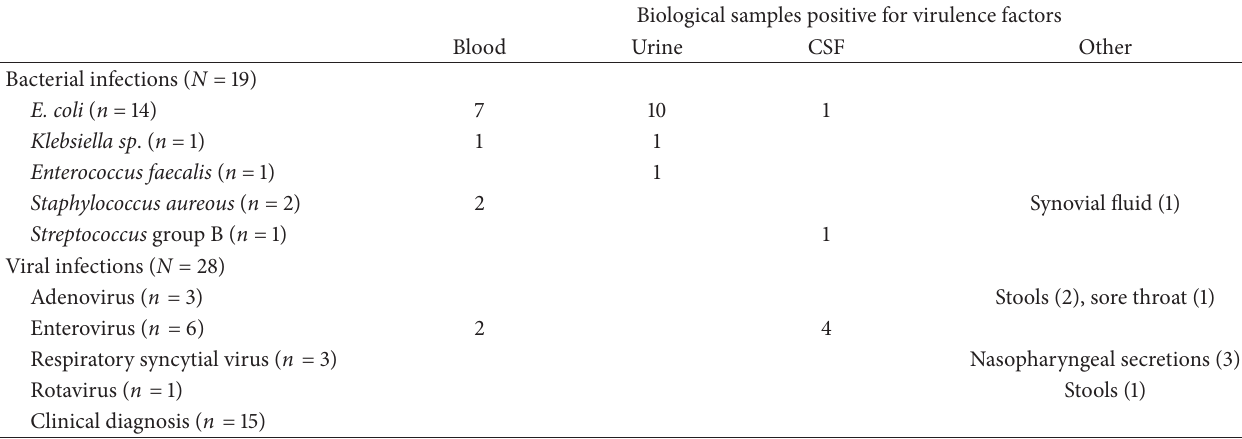
Table 1: Causes of infection in infants